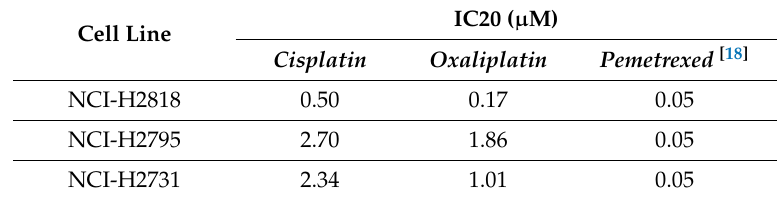
Table 2. Inhibitory concentrations of cisplatin and oxaliplatin used for subsequent experiments.